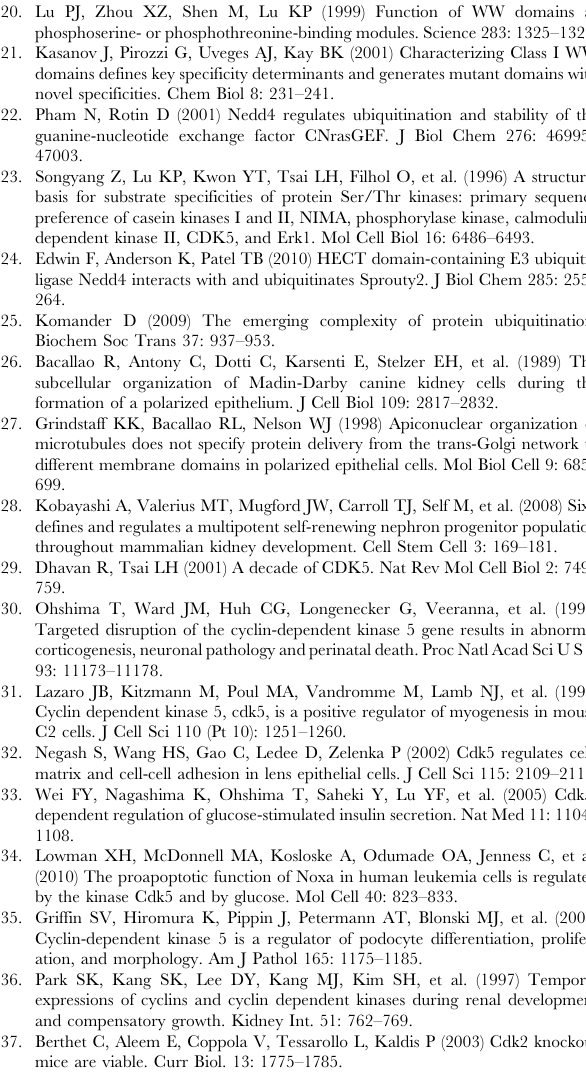
the indicated antibodies. B . Kidneys from E17.5 CDK5 mutant embryos were lysed with sample buffer and then separated by SDS-PAGE followed by immunoblotting with